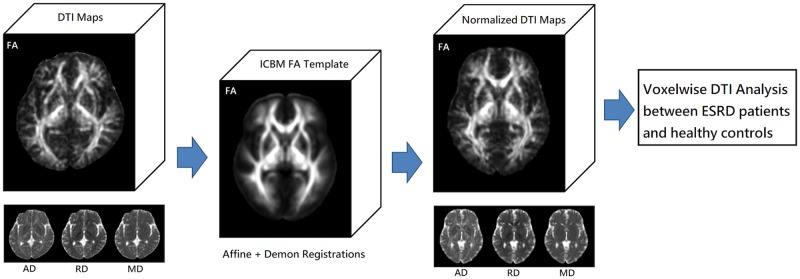
The post-processing steps of voxelwise DTI analysis.After scalp stripping, individual whole-brain DTI maps are spatially normalized to an international consortium for brain mapping (ICBM) FA template using linear affine and non-linear diffeomorphic demon registrations. Subsequently, the normalized DTI maps are utilized in voxelwise DTI analysis to show the differences between ESRD patients and healthy controls.